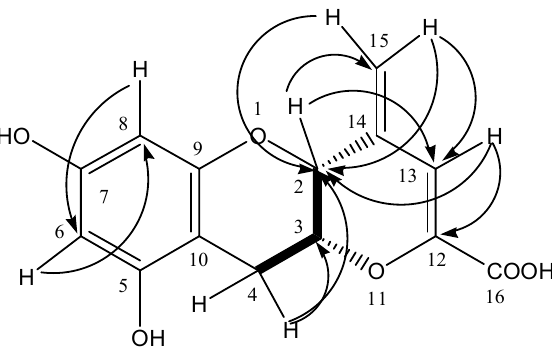
Figure 4. Nuclear Magnetic Resonance (NMR) spectrometry assay of compound 1: ( a ) Heteronuclear Multiple Bond Correlation (HMBC); ( b ) Heteronuclear Singular Quantum Correlation (HSQC); ( c ) Total Correlation Spectroscopy (TOCSY).